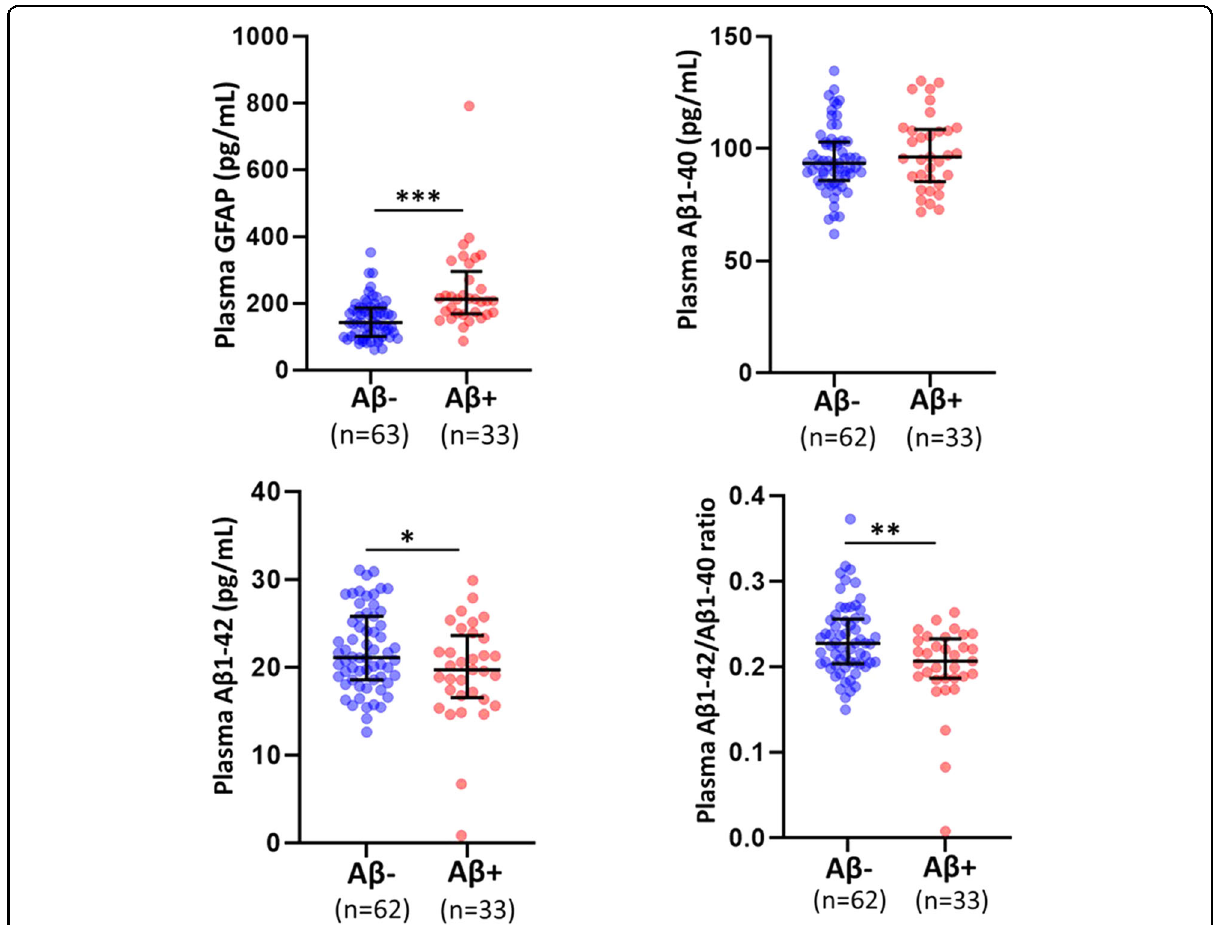
Fig. 1 Comparison of plasma GFAP, A β 1 – 40, A β 1 – 42, and A β 1 – 42/A β 1 – 40 ratios between A β − and A β + cognitively normal older adults.